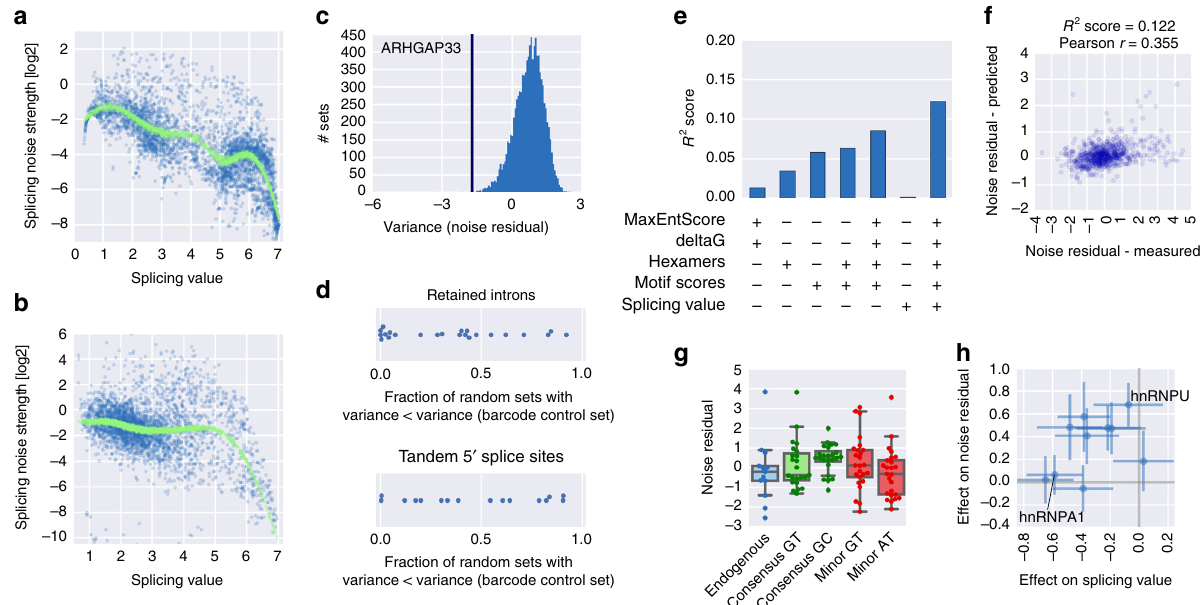
Fig. 6 Cell-to-cell variability of alternative splicing can be encoded in the DNA sequence. a , b Noise strength (variance/mean) is plotted against mean splicing values for the retained intron ( a ) and tandem 5 ′ splice site ( b ) libraries. c Example result for comparing the variance of noise residuals for groups of individual barcode controls to variances for 10,000 sets of equal size, randomly picked from library variants in the same range of splicing values. The vertical blue line indicates the variance of the barcode control group. d The x -axis denotes the fraction of random sets with a variance smaller than the one of the corresponding barcode control set for groups of identical splice site sequences from the retained intron (top) and tandem 5 ′ splice site (bottom) libraries. e R 2 scores for predicting splicing noise residual using the indicated features. f Measured noise residuals are plotted against predictions based on the full set of features in panel ( e ). g Distribution of noise residuals in retained intron library variants with the indicated sequence (endogenous or a consensus sequence) at donor and acceptor splice sites; boxes show the quartiles of the dataset, whiskers show the range of the distribution not including outliers (displayed as points); green indicates processing by the major and red processing by the minor spliceosome. h Mean and standard error of the mean of the effect on splicing values ( x -axis) and on noise residuals ( y -axis) of introducing a motif for the indicated splicing factor in and around retained introns. Several points of insertion are treated as one set ( n = 4 – 18 in each differences in the experimental layout and the sequence context